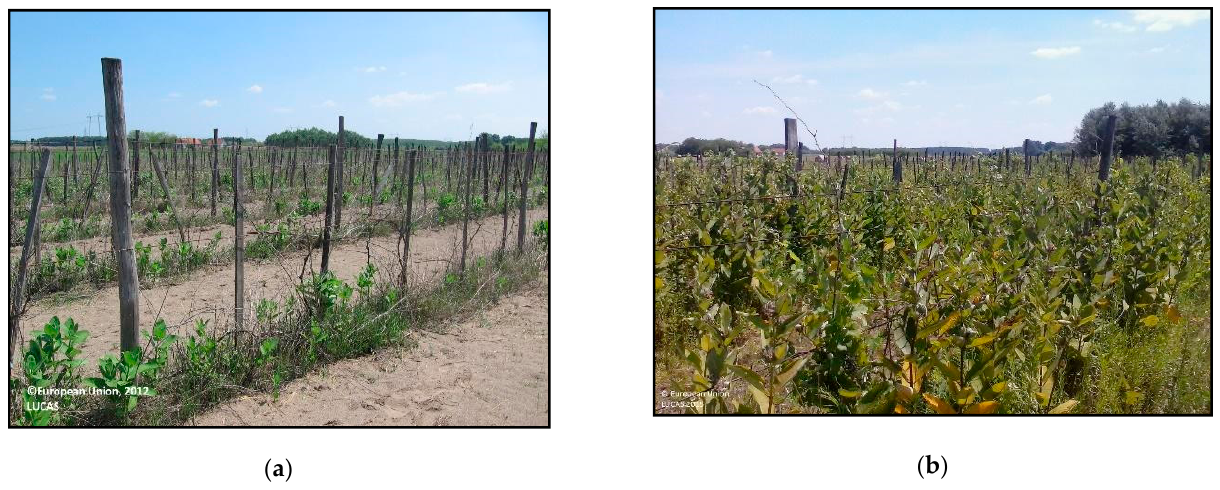
Figure 1. Rapid spread of common milkweed in an abandoned vineyard between ( a ) 2012 and ( b ) 2015 in the Hungarian Great Plain, according to the Eurostat LUCAS land-use and land-cover database field survey photos.